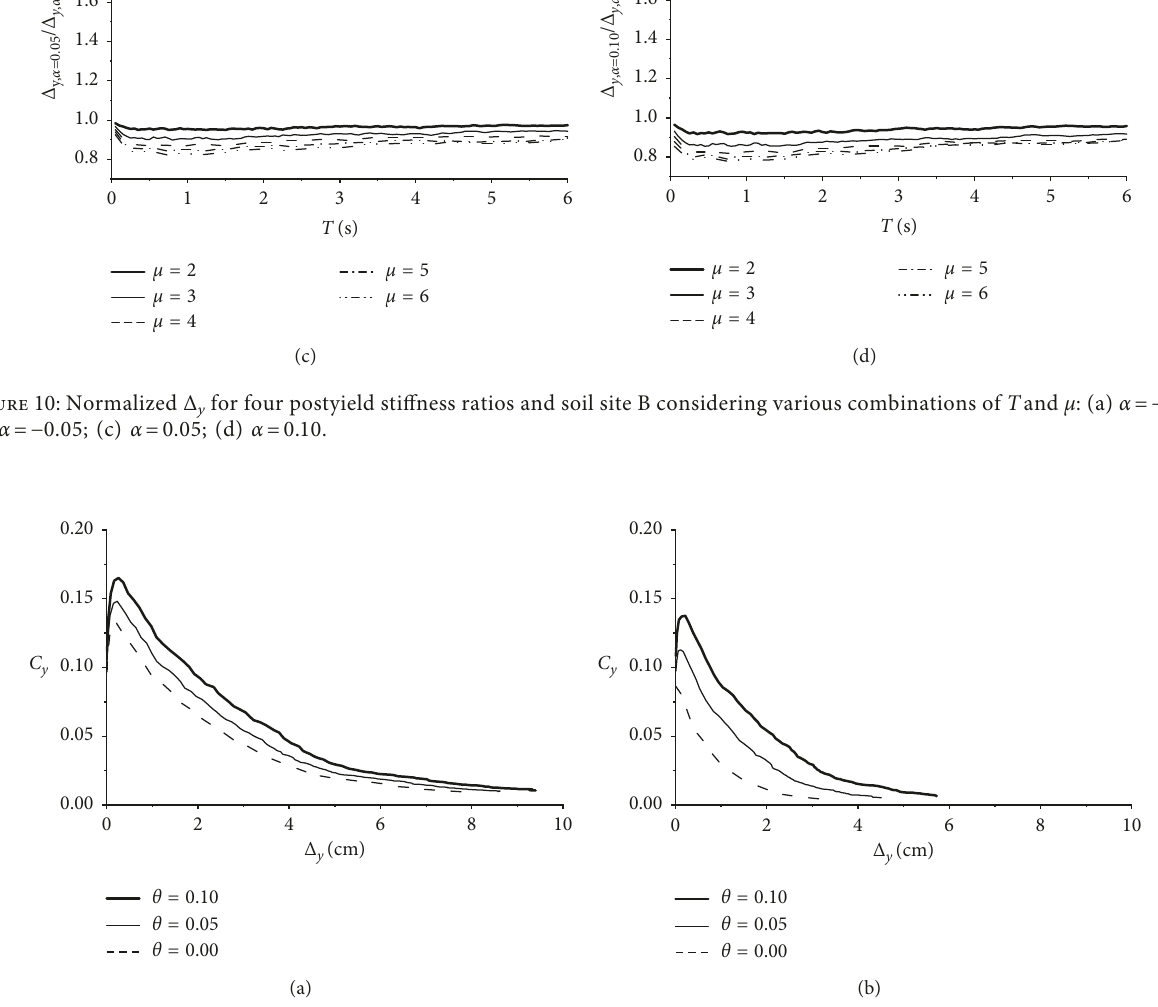
Figure 11: Effects of θ on YPS for soil site B considering two ductility factors: (a) μ � 2; (b) μ �